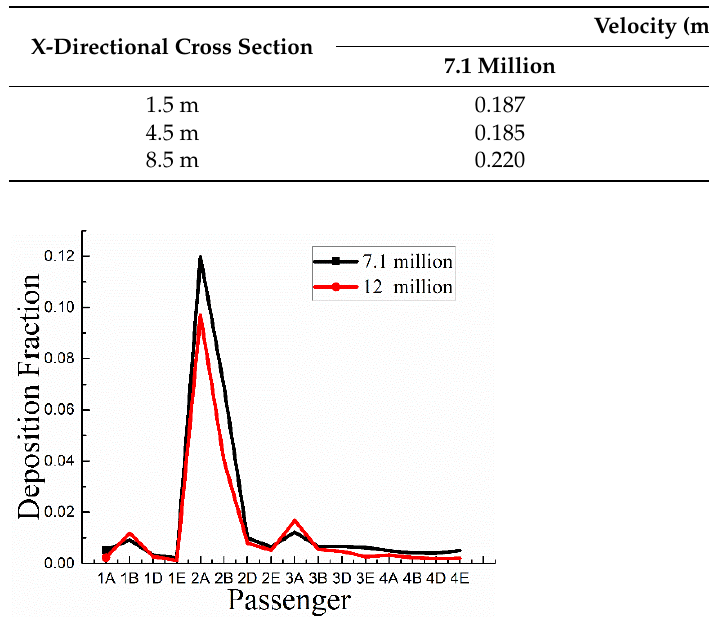
Figure 5. The verification of grid independence with deposition fraction on passengers.